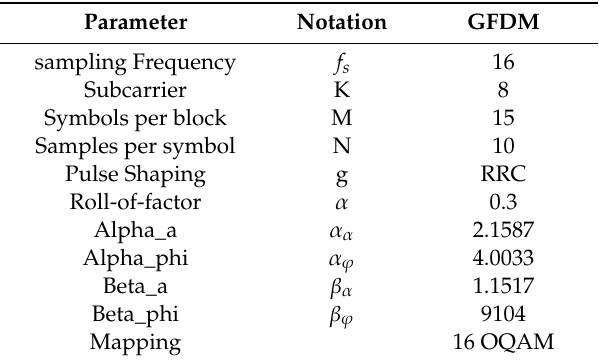
Table 1. Simulation